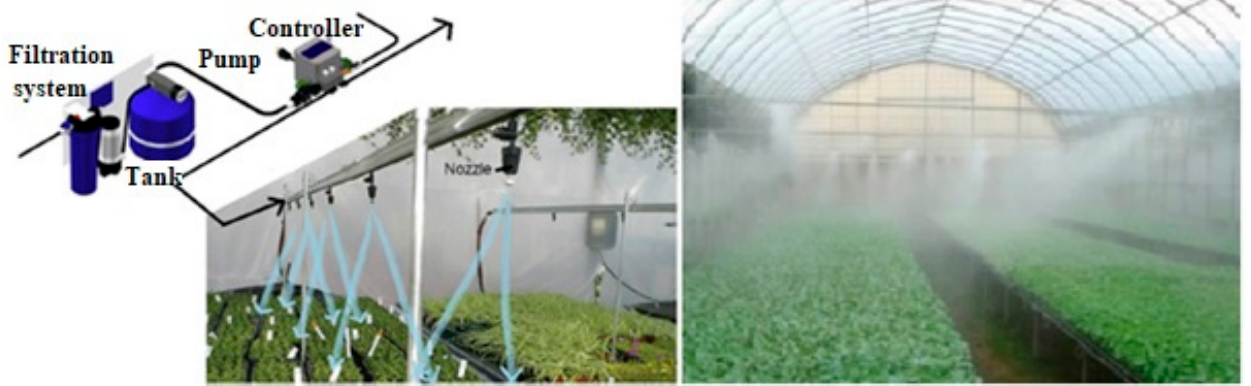
Figure 7. Schematic of cooling by a fogging system. Reprinted with permission from Ref. [97]. Copyright 2019